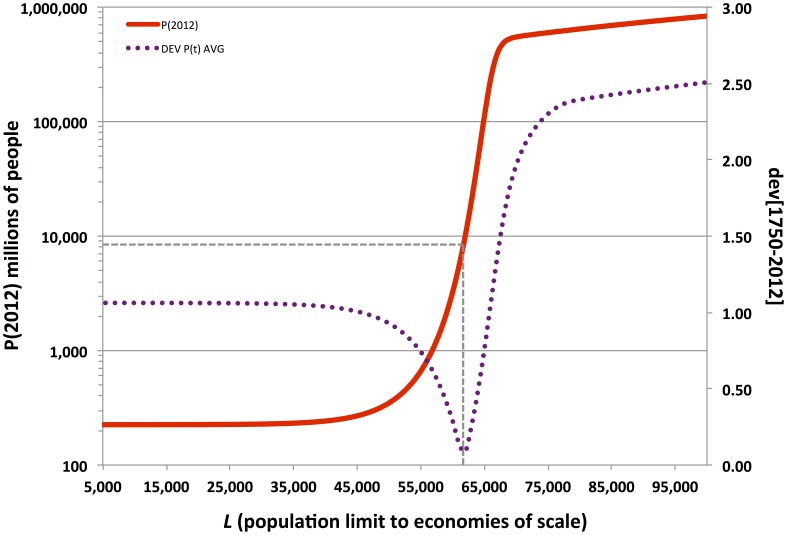
Scatterplot of modeled population in 2012 CE (P2012 CE) and the overall modeled trajectory's deviation from historical estimates and census data (here labeled dev[1750–2012] for clarity, defined as  in the text and Tables 2 and 3) versus the cultural systemic limit to achieving economies of scale, L.The case shown involves ; ; and .